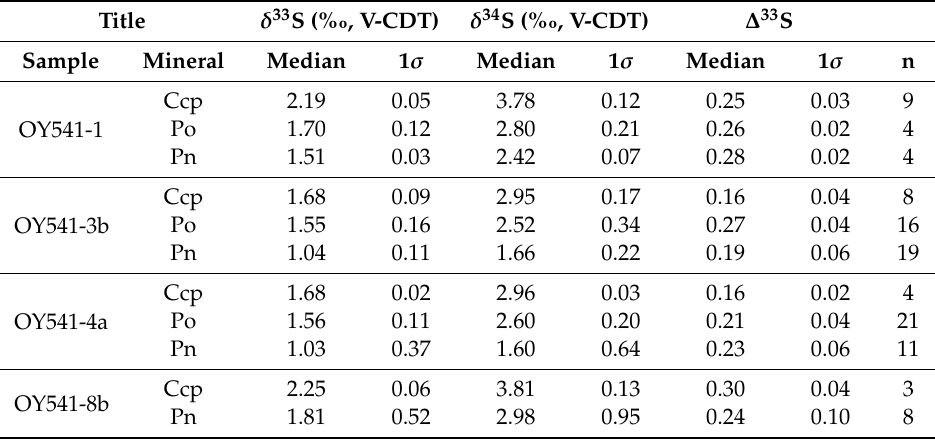
Table 6. Median values and standard deviations of sulphur isotope